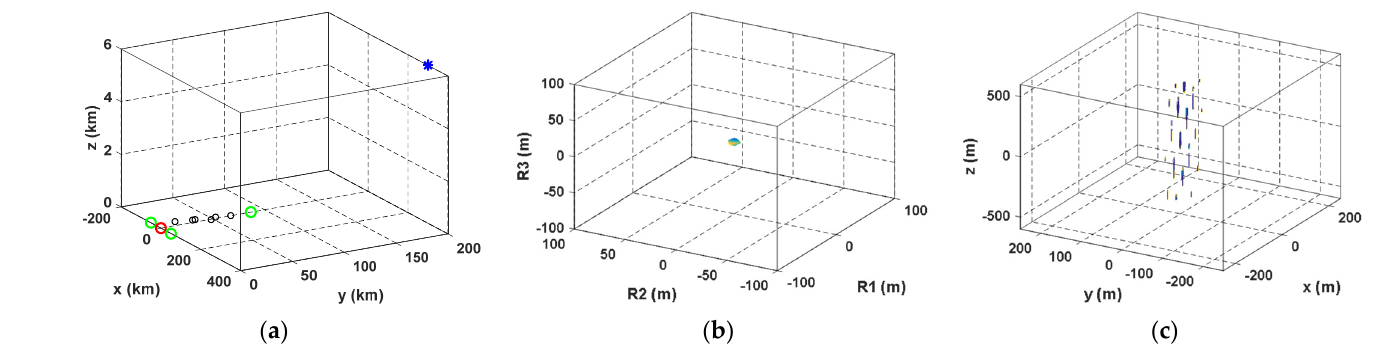
Figure 7. ( a ) Geometry of the receiver network with the lightning flash at [100, 120, 6] km; ( b ) in the RD space, the equivalence cell is a point; ( c ) in the geographic space, the equivalence cell diffuses significantly.